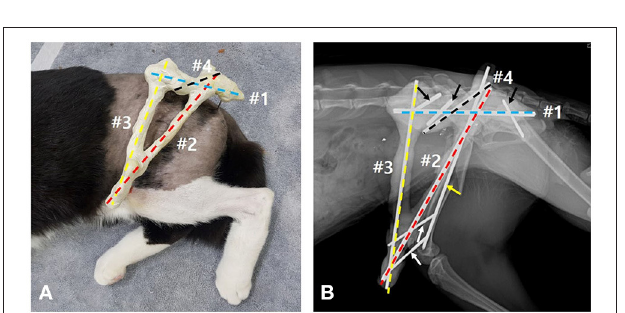
FIGURE 3 | (A,B) Triangular frame composed of connecting bars with epoxy-putty molded pins for trans-articular external skeletal fixation of the hip: the 3.0-mm Steinmann pin (#1, blue dashed line) links the fixation pins placed in the left pelvis (black arrows); the other 3.0-mm Steinmann pin (#2, red dashed line) links to the fixation pins placed in the distal segment of the fractured femur (white arrows); #1 and #2 connecting bars are linked to each other at the intersection; the 2.4-mm Steinmann pin (#3, yellow dashed line) links to the #1 and #2 connecting bars; the other 2.4-mm Steinmann pin (#4, black dashed line) is tied into the intramedullary pin (yellow arrow) and links to the #1 connecting bar. Epoxy-putty covers all the pins composed of connecting bars including column of the pins and those